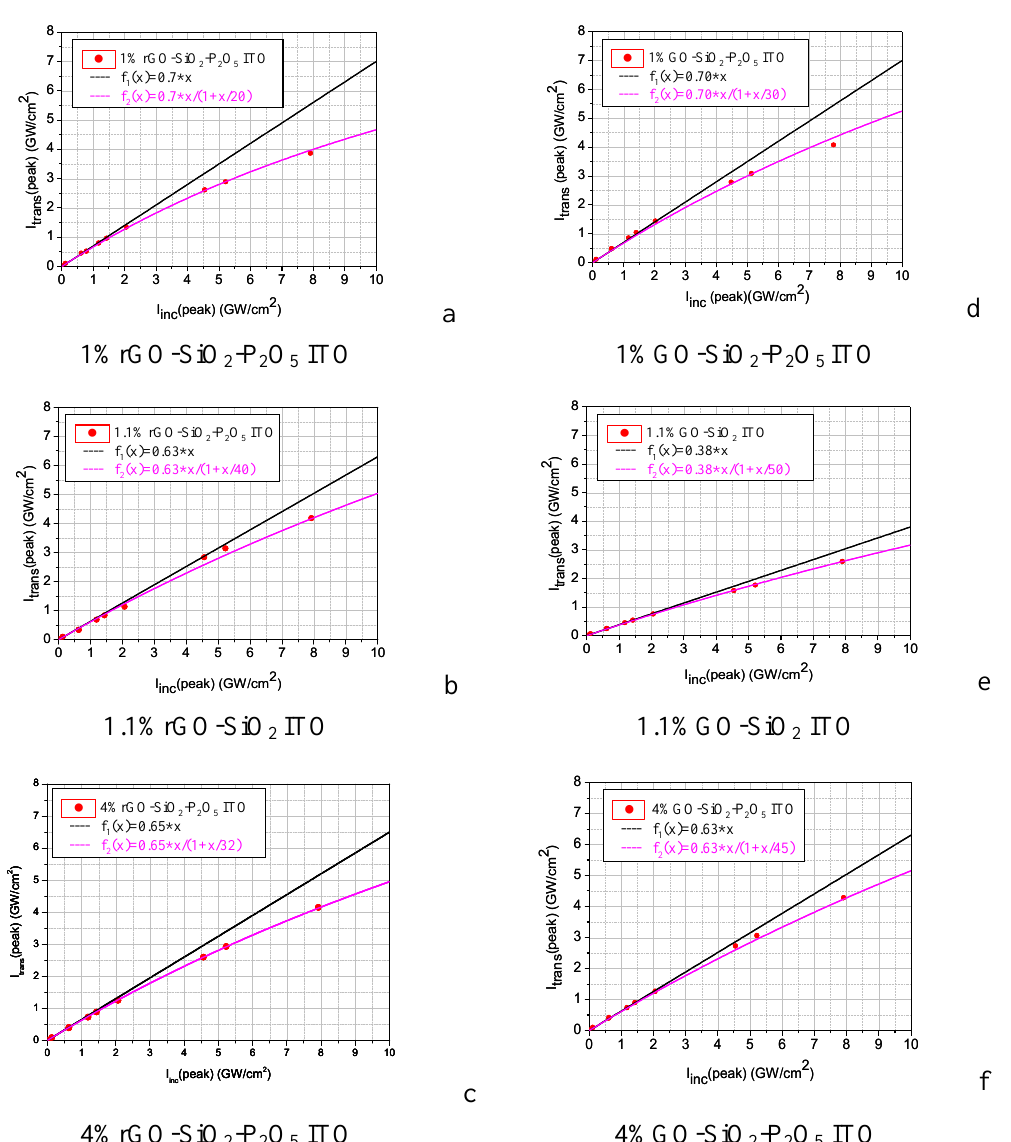
Figure 19. The experimental transmittance results for the films deposited on ITO-coated glass substrates, for the two categories of the investigated silico-phosphate composite samples: with rGO ( a – c ) and with GO ( d – f ).